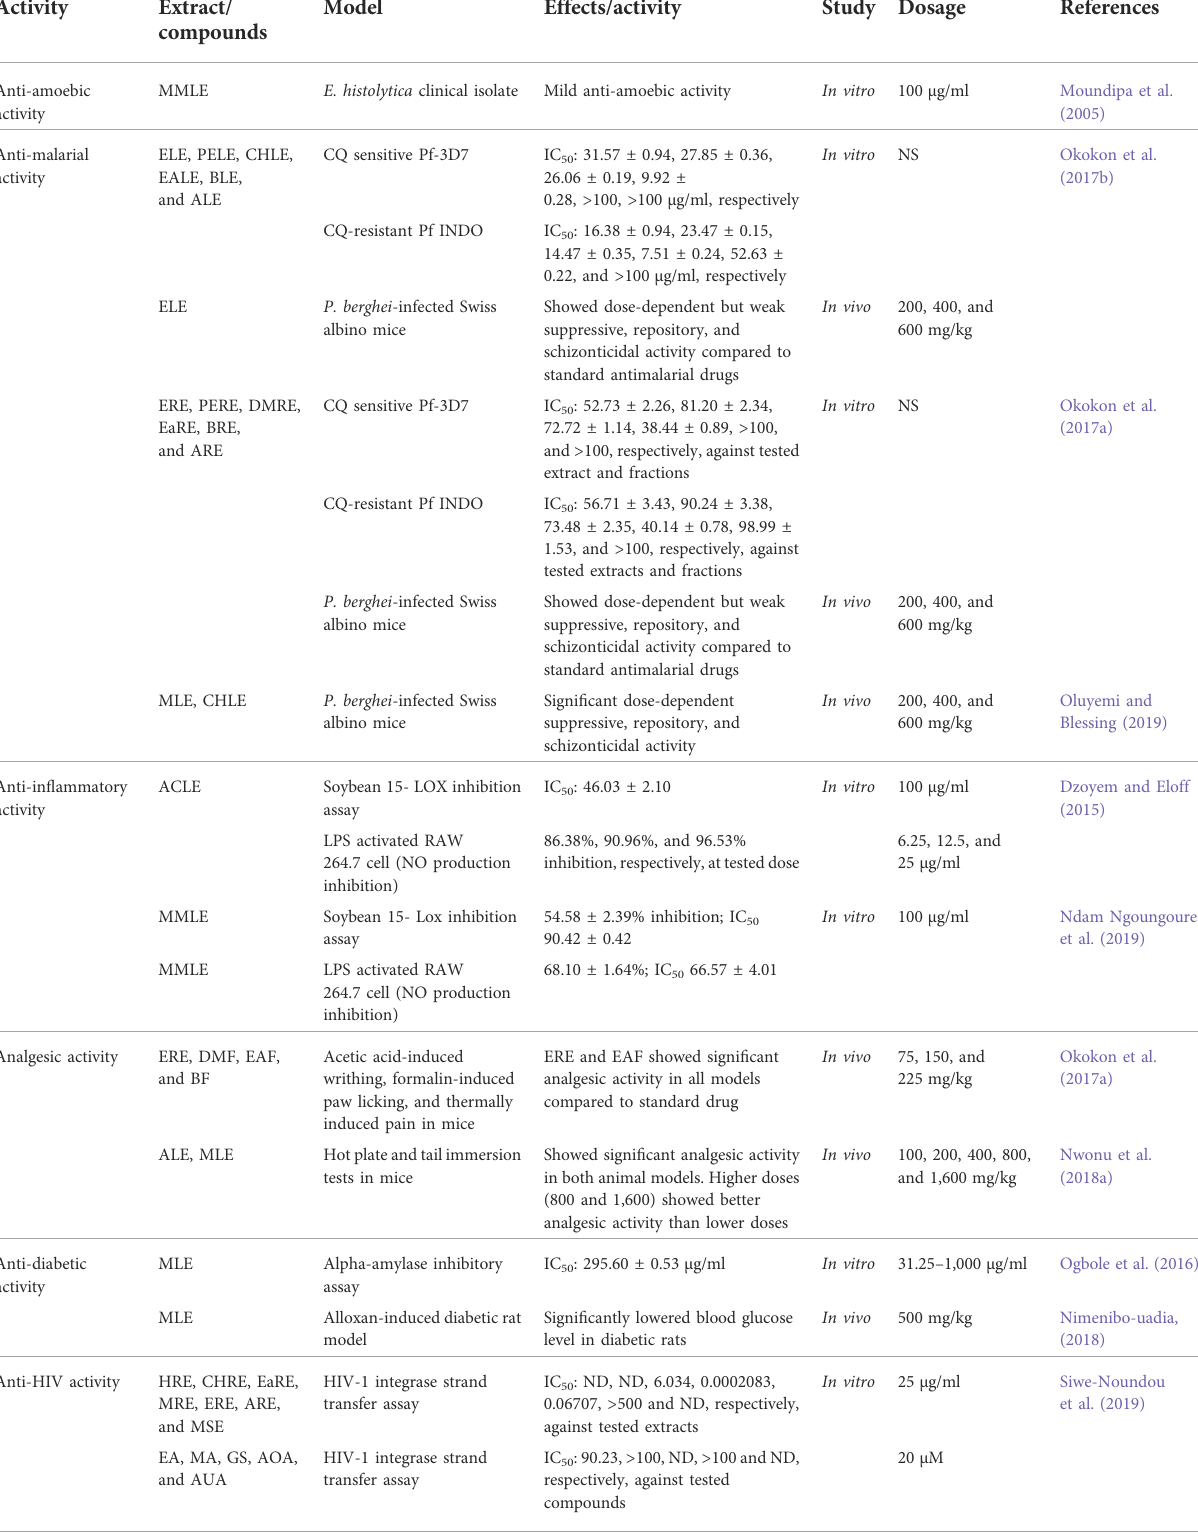
TABLE 4 Pharmacological activities of extracts/fractions and compounds of A. laxi fl ora